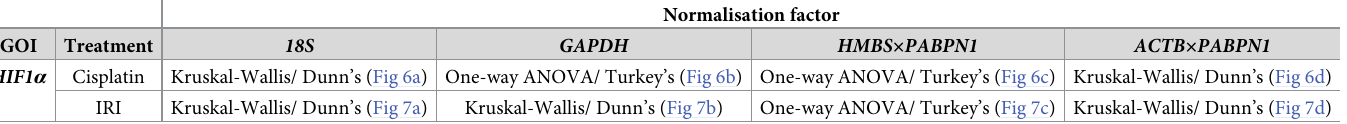
Table 11. Statistical methods used to analyse HIF1 α gene expression.